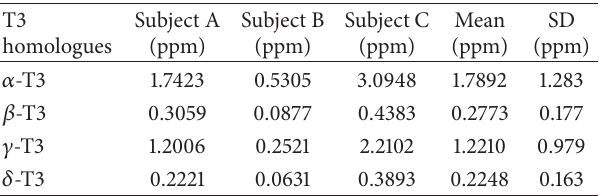
Table 4: Average concentrations of T3 homologues detected in human plasma of 3 male